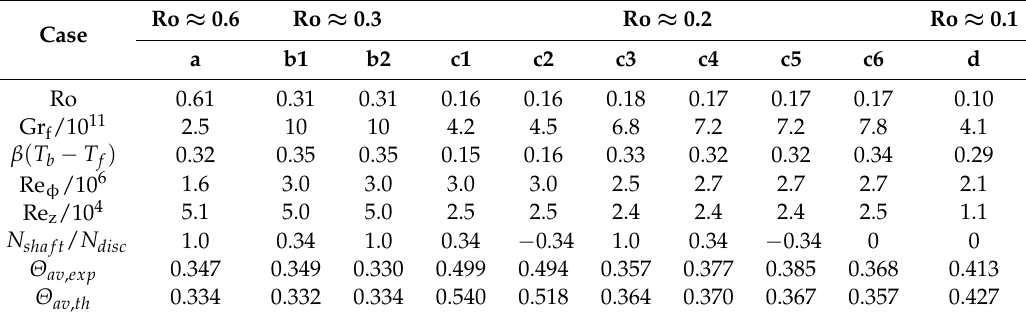
Table 2. Flow parameters and experimental and theoretical average disc temperatures